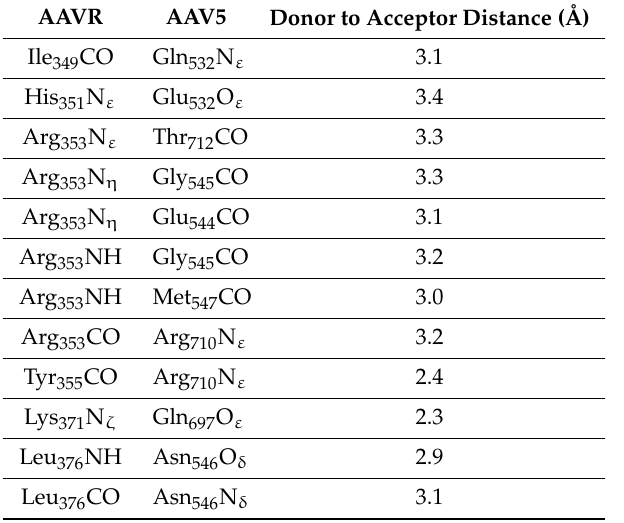
Table 4. Potential AAVR-AAV5 intermolecular hydrogen bonds and salt bridges.